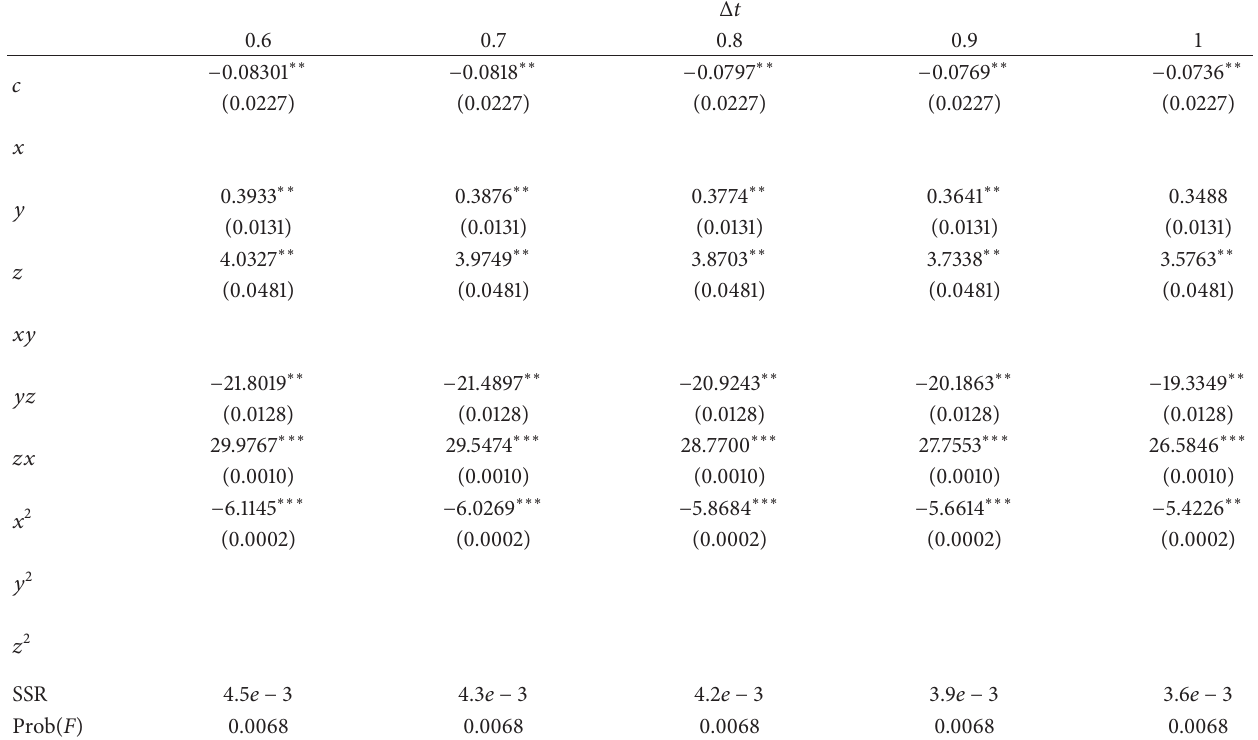
Table 2: The first equation in (9) under the several time steps of discretization.